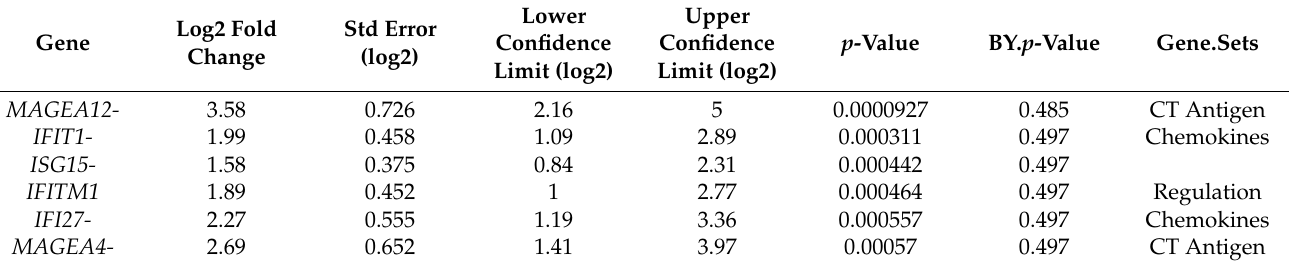
Figure 3. Immune gene expression in mUC samples. ( A ) Heatmap of the normalized gene expression generated via unsupervised clustering. Red indicates high expression; blue indicates low expression (log2 scale). ( B ) Volcano plot displaying each gene’s − log10 ( p -value) and log2 fold change between non-responders (NR) and responders (R). Statistically significant expressed genes (below the given p -value threshold [<0.05]) are marked in red. Table 2. Differentially expressed genes in NR vs. baseline